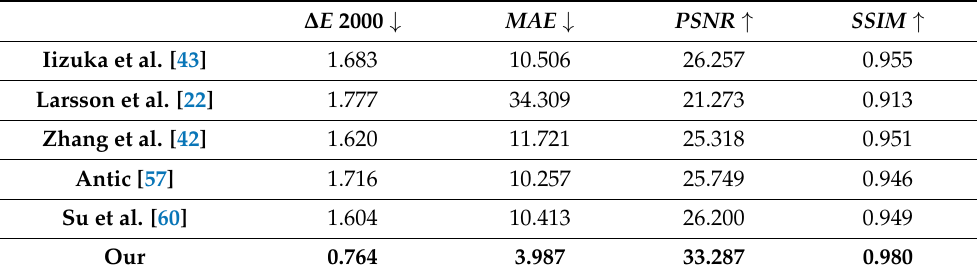
Table 3. Average metric values for some 50 aerial images colorized with some existing deep-learning methods and the proposed Hyper-U-Net method.